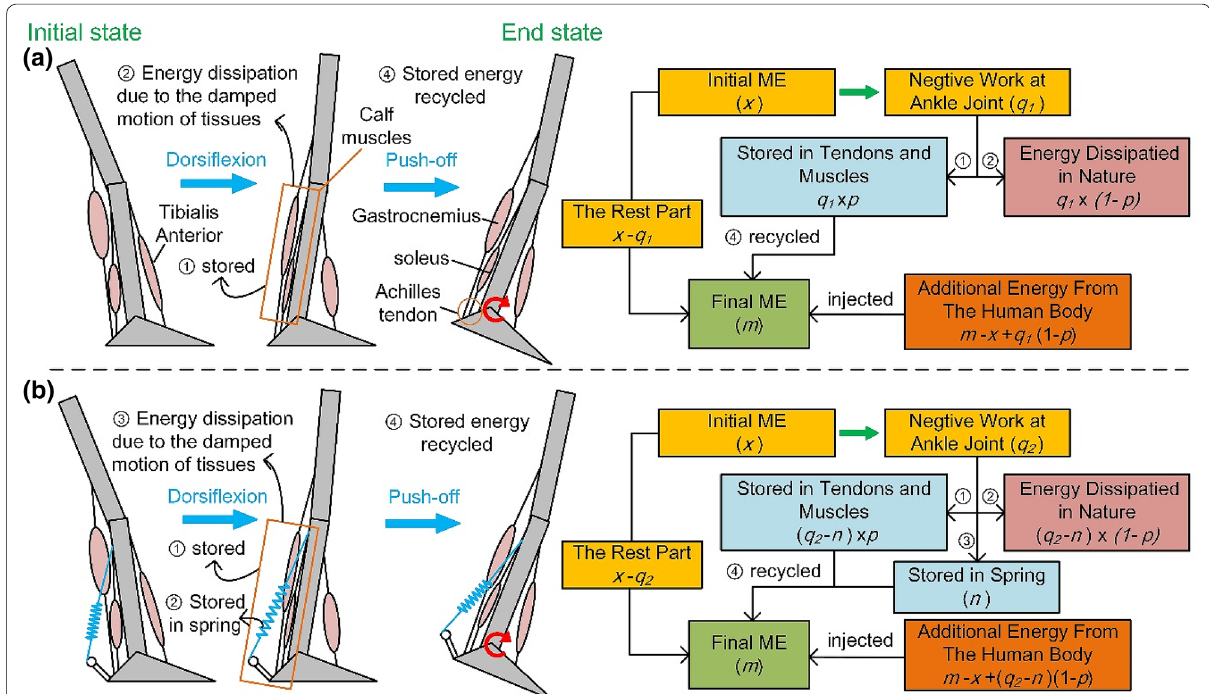
Figure 1 Energy conversion model: a Walking without the elastic component. b Walking with the elastic component, (both cases experience the same walking process from HS to PO, where the initial ME and final ME in both cases are the